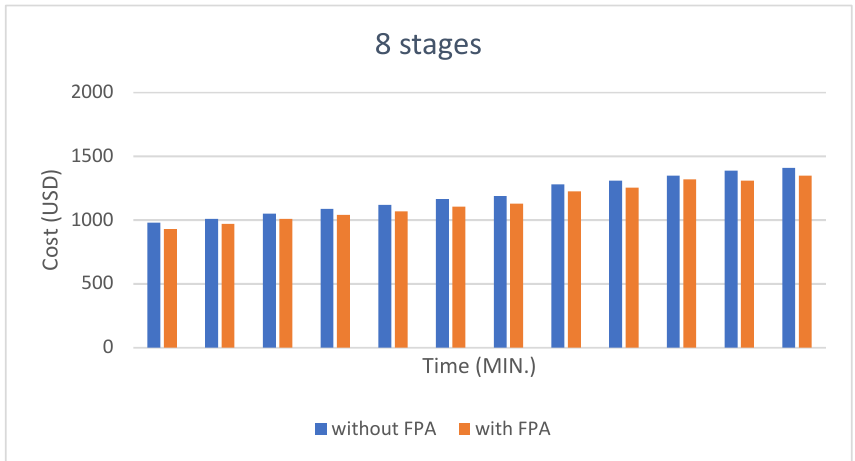
Figure 7. Comparison of Results for 8 stages with and without FPA.